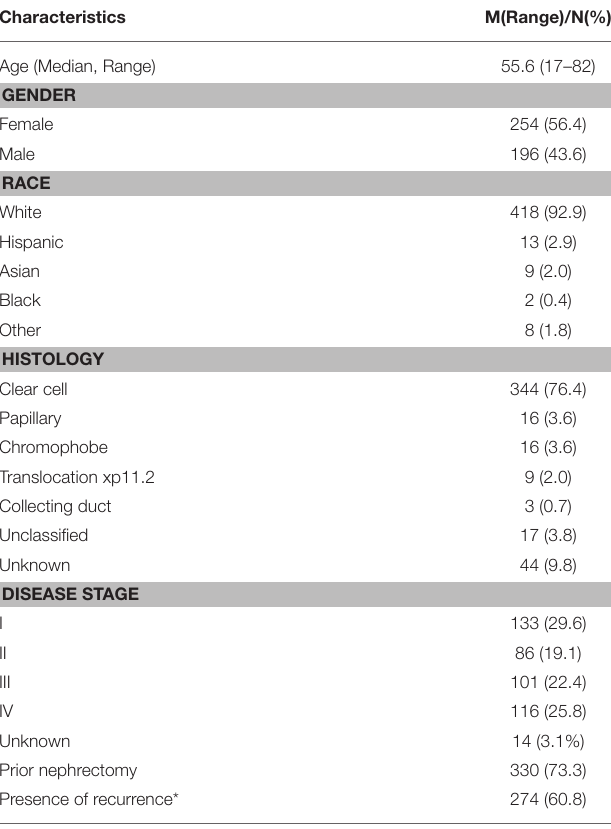
TABLE 3 | Demographic and clinical characteristics ( N = 450).